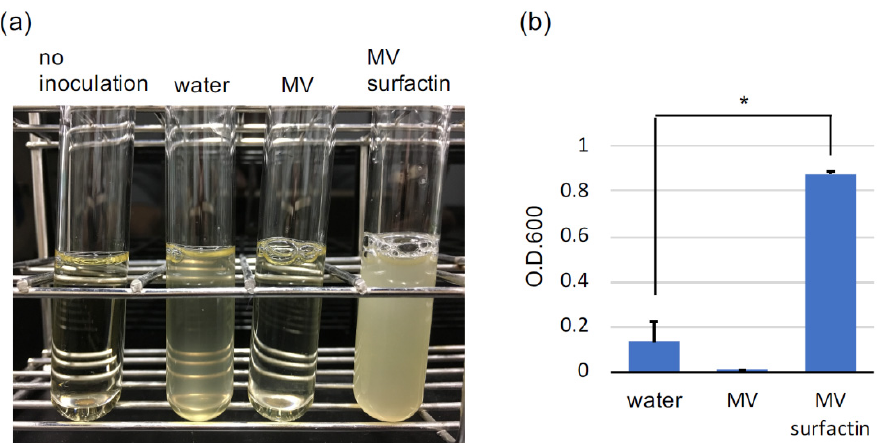
Figure 1. C. thermocellum growth stimulation by the MV constituents. C. thermcellum was cultured in CTFUD medium for 24 h with the supplementation of water, the MV fraction, or the surfactin- treated MV fraction. The cultures ( a ) and their optical densities ( b ) are shown. The experiment was duplicated. Error bars show standard error. * Student’s t -test p < 0.01.